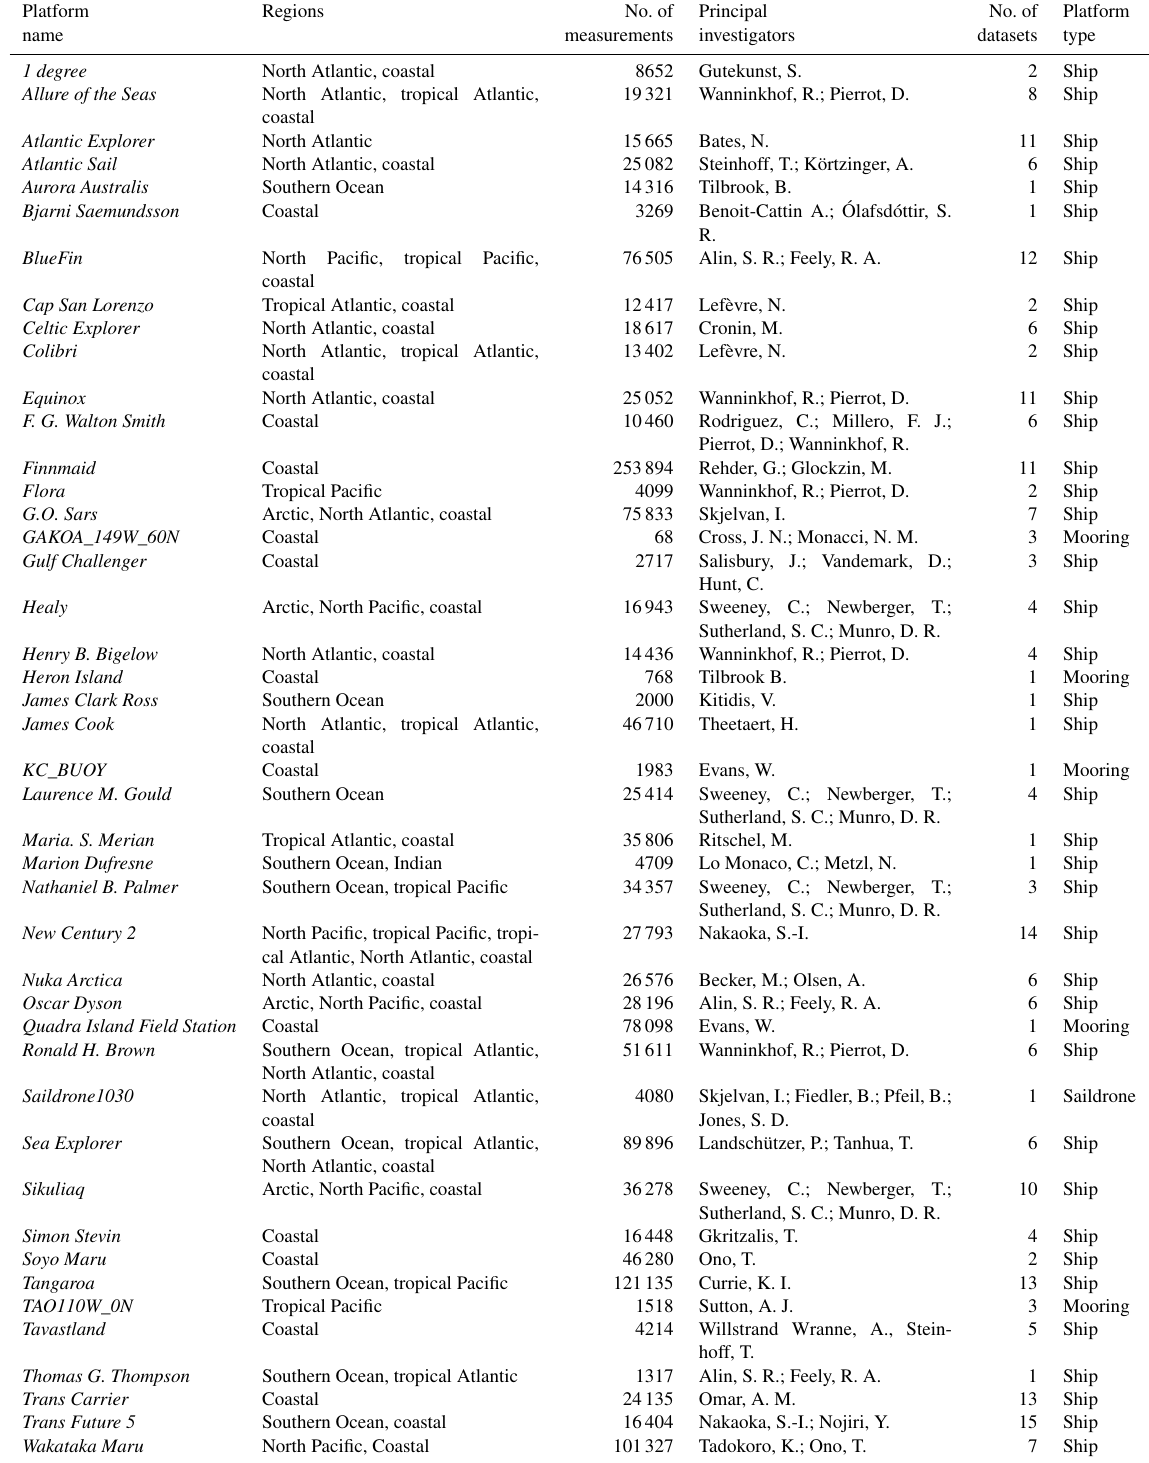
Table A5. Attribution of f CO 2 measurements for the year 2020 included in SOCATv2021 (Bakker et al., 2016, 2021) to inform ocean f CO 2 -based data